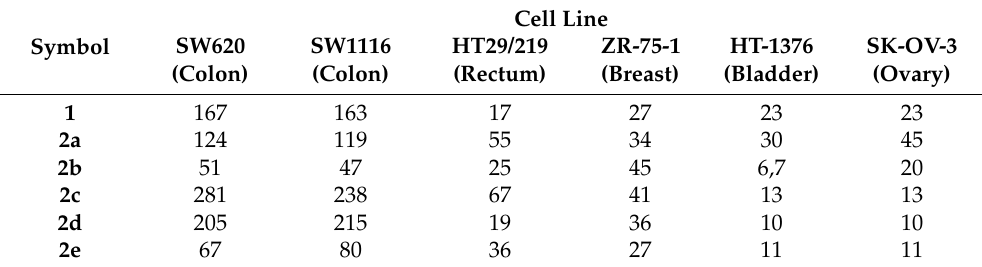
Figure 1. Structural comparison of organogold derivatives 2a – e , 4 with cisplatin ( 1 ). Table 1. Comparison of IC 50 ( µ M) for complexes 2a – 2e and cisplatin ( 1 ) against selected human cell lines